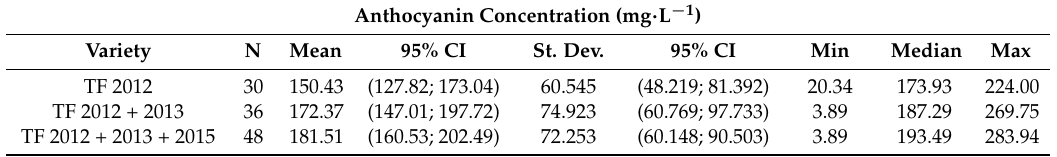
Table A7. Descriptive statistics of the samples used in the external test sets for the prediction of anthocyanin concentration.